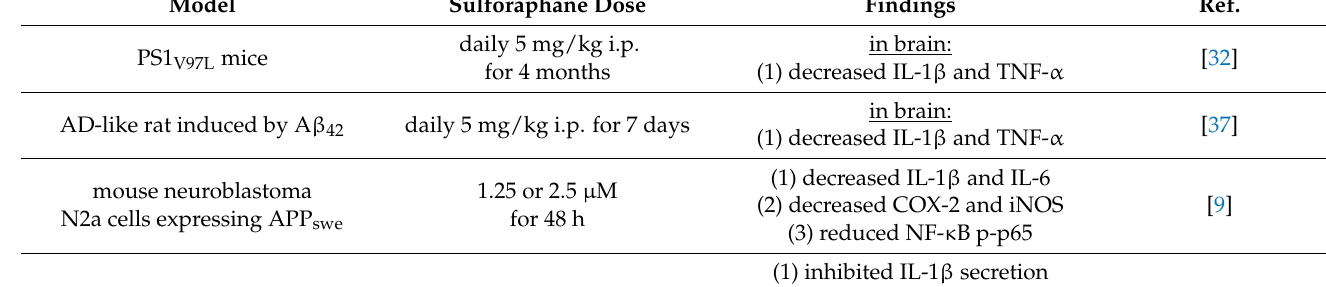
Table 3. The effects of sulforaphane on Alzheimer’s disease (AD)-associated inflammatory biomarkers in AD-like models. Model Sulforaphane Dose Findings Ref. daily 5 mg/kg i.p. in brain: [32] PS1 V97L mice for 4 months (1) decreased IL-1 β and TNF- α in AD-like rat induced by A β 42 daily 5 mg/kg i.p. for 7 days